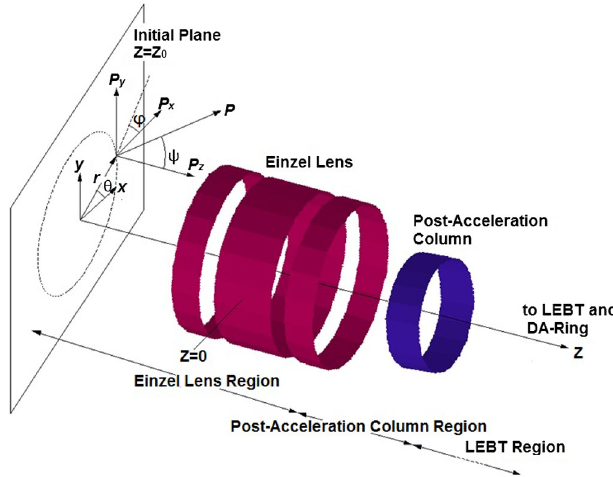
FIG. 23. Schematics of the simulation region and the coordi- nate used in the simulation code for the upper region from the initial plane to the end of the post-acceleration column.